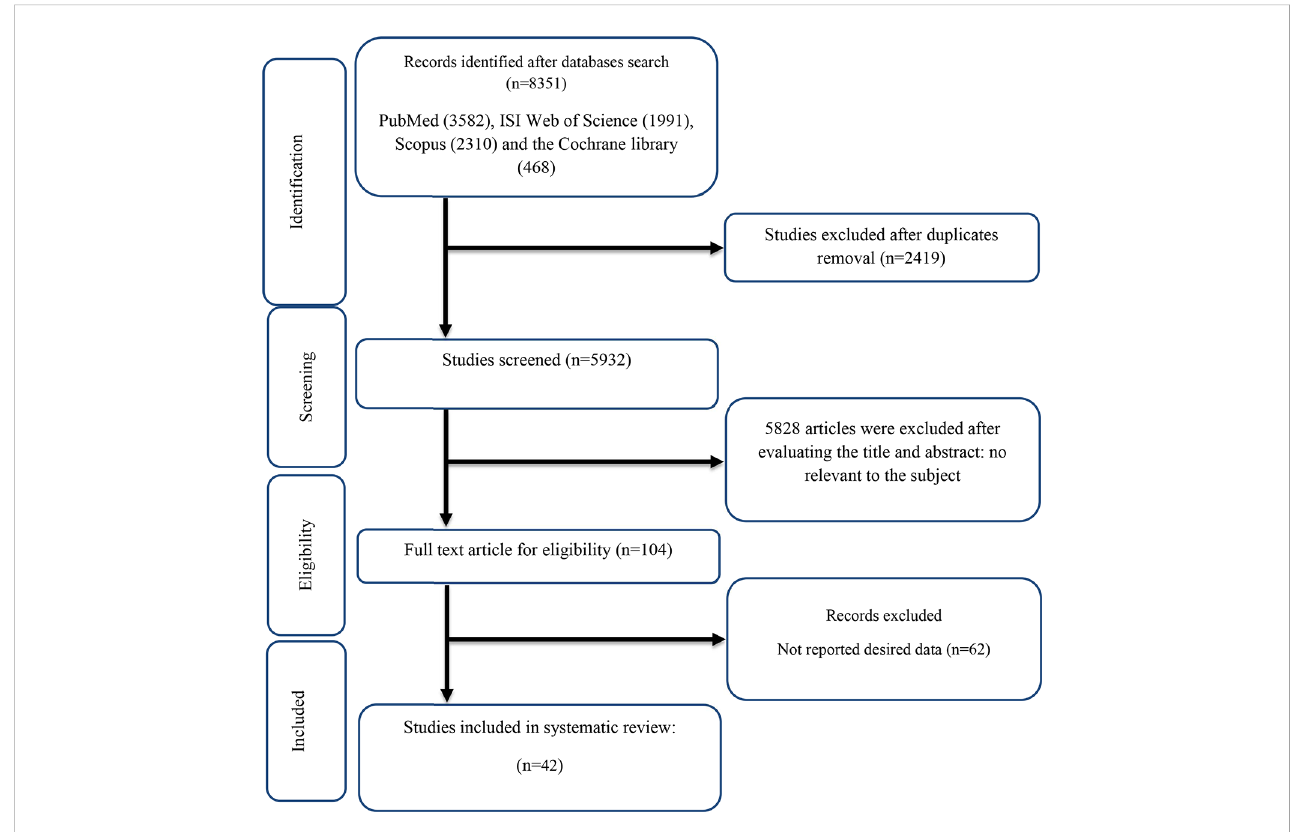
FIGURE 1 Flow chart of study selection for inclusion trials in the systematic